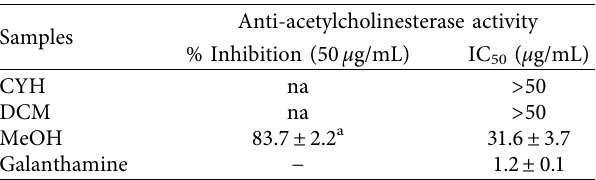
Table 5: Anti-acetylcholinesterase activity of R. crispus extracts.